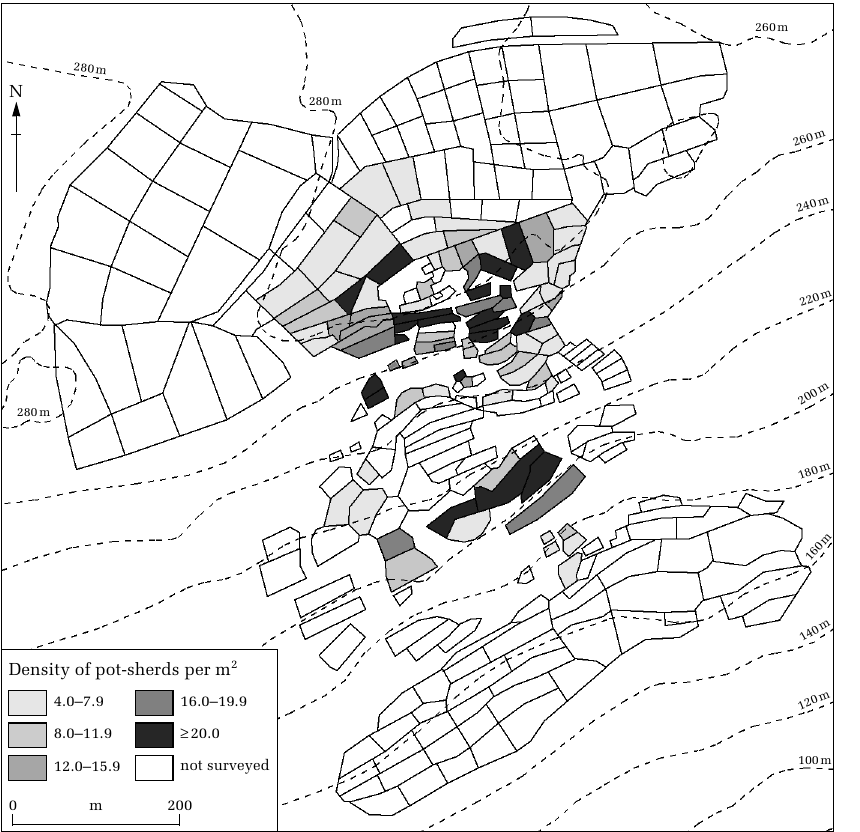
Figure 3 The site at Markiani, Amorgos, showing its situation on the summit and upper southern slope of the hill, and the variation in the surface density of